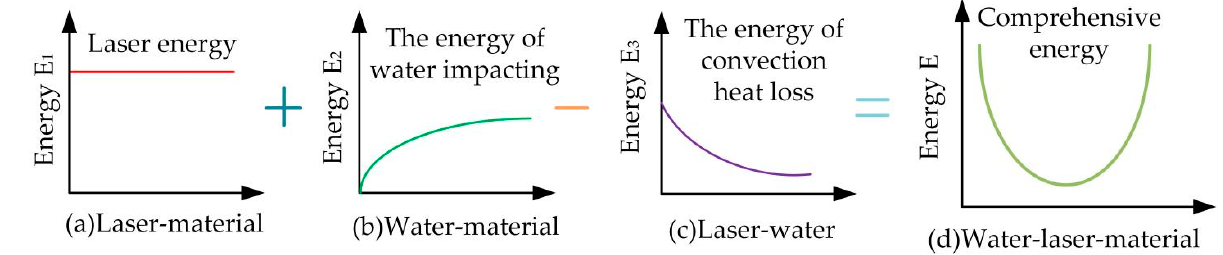
Figure 3. Schematic diagram of the comprehensive energy change during water laser compound machining.